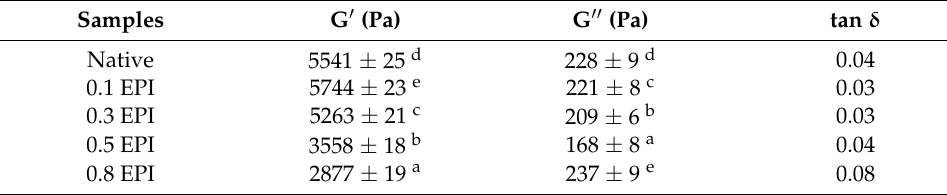
Table 3. G (cid:48) , G (cid:48)(cid:48) and tan δ value of native and modified starches.